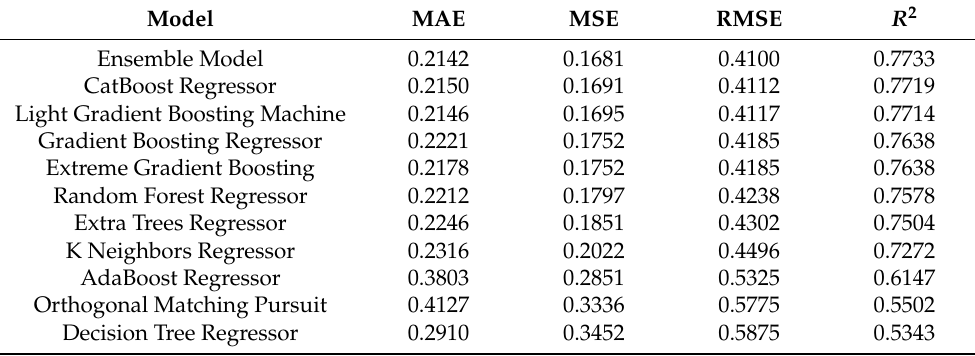
Table 5. Model performance for Rainfall